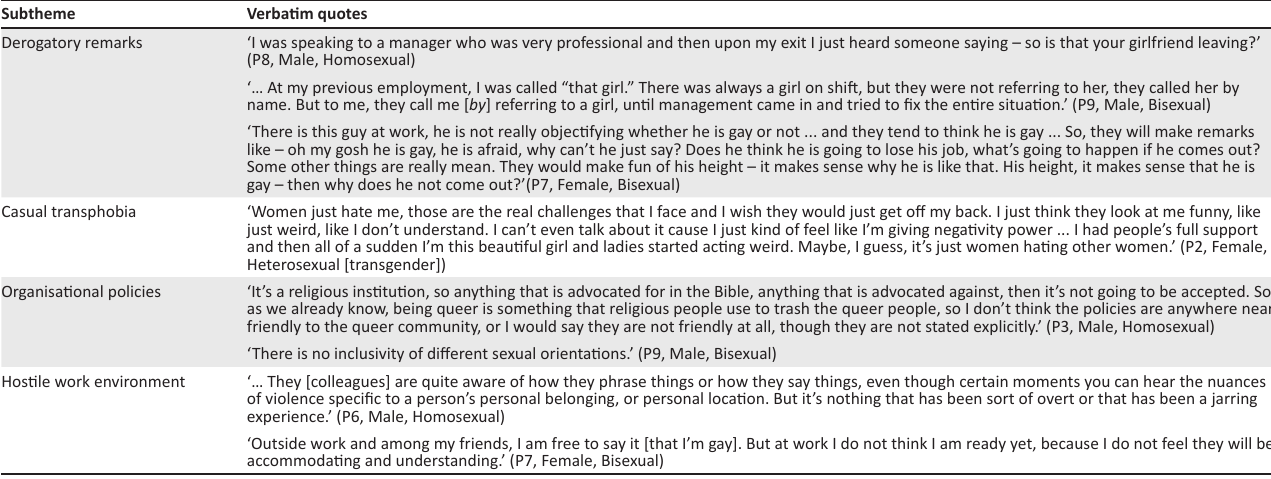
TABLE 2: Sub-themes generated from responses in terms of the discriminatory challenge. Subtheme Verbatim